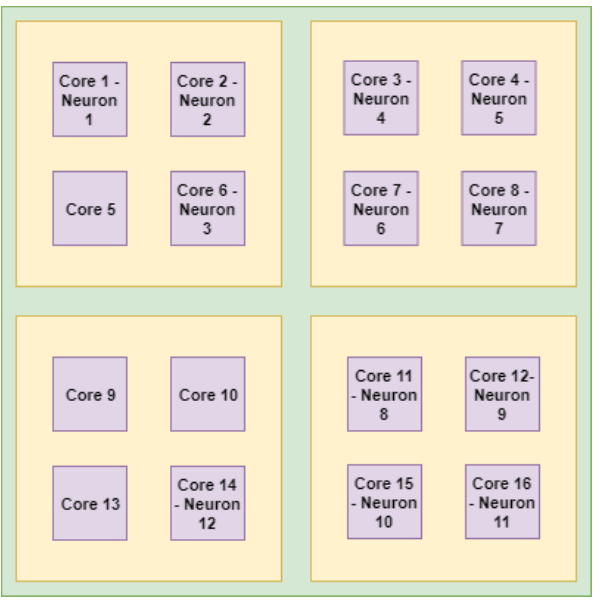
Figure 13. Level-2 mapping for 16-cores architecture using multilevel mapping